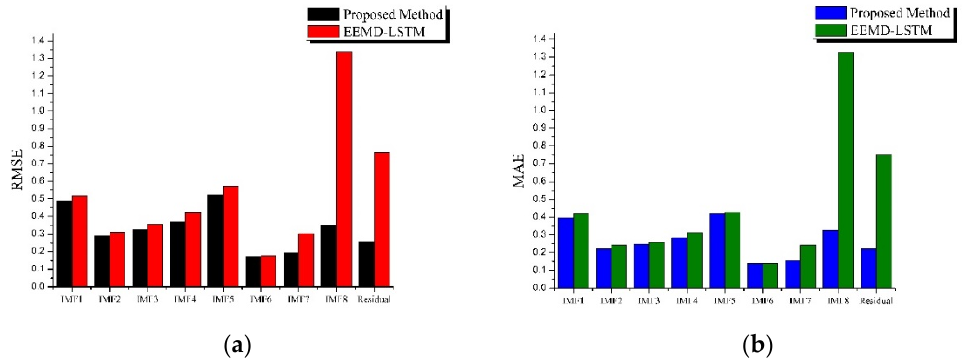
Figure 9. Error estimate results for propagation-loss subsequences in an oceanic evaporation duct: ( a ) root mean square error (RMSE); ( b ) mean absolute error (MAE).